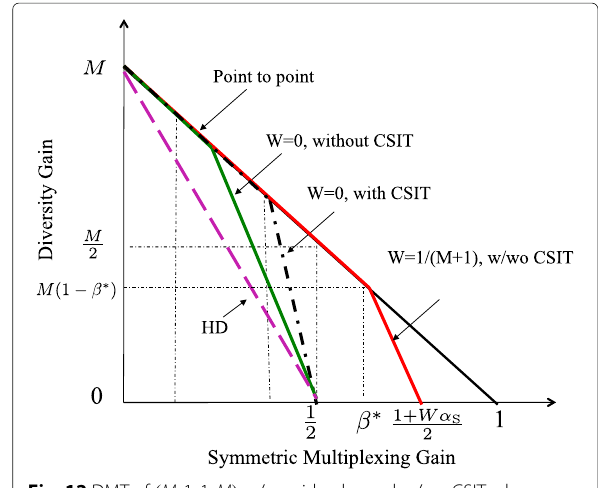
Fig. 12 DMT of ( M ,1,1, M ) w/wo side-channel w/wo CSIT